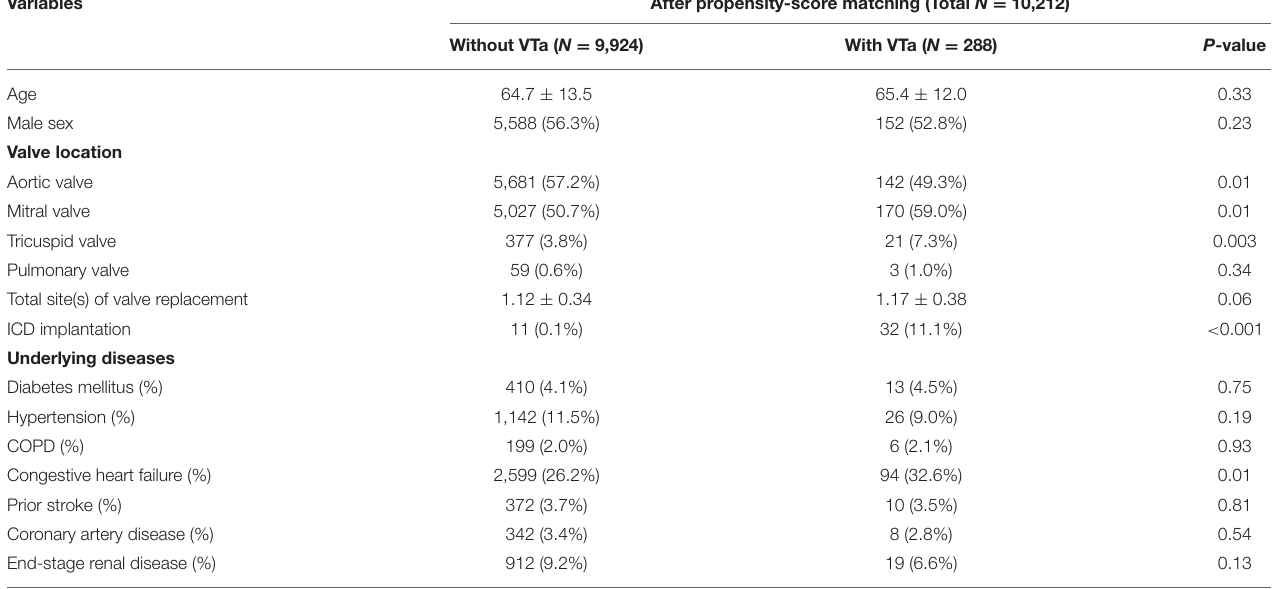
TABLE 4 | Baseline characteristics of patients with and without VTa after valve replacement.